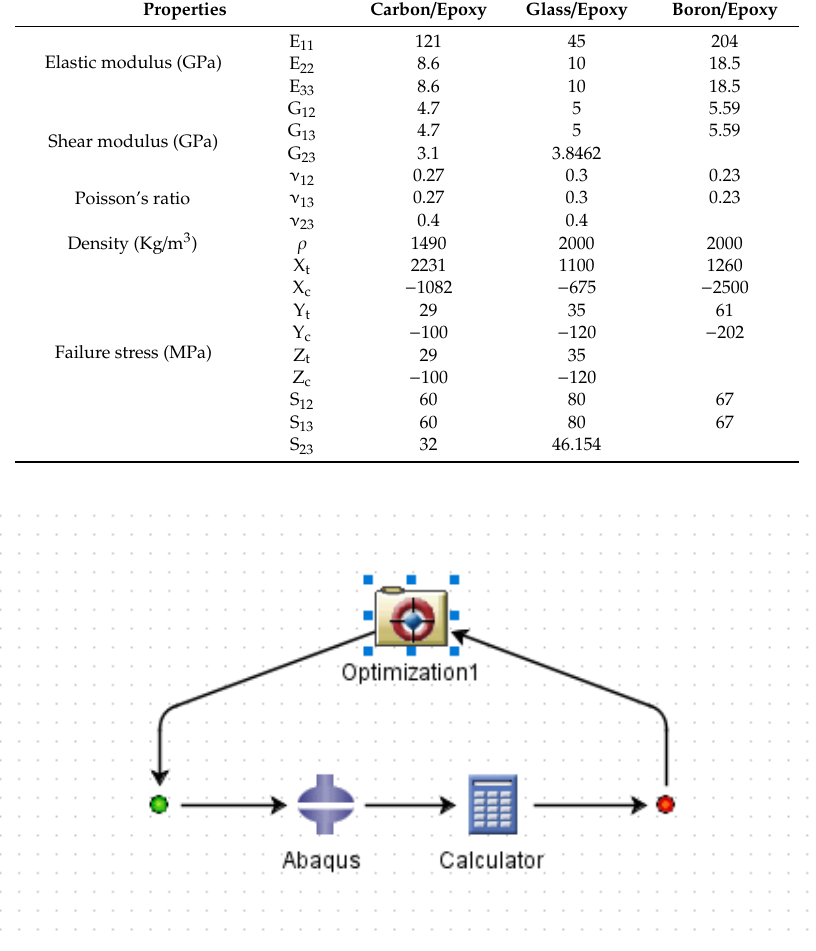
Figure 3. ISIGHT runtime gateway interface. Table 1. Material properties of carbon/epoxy, glass/epoxy, and boron/epoxy [10,55].